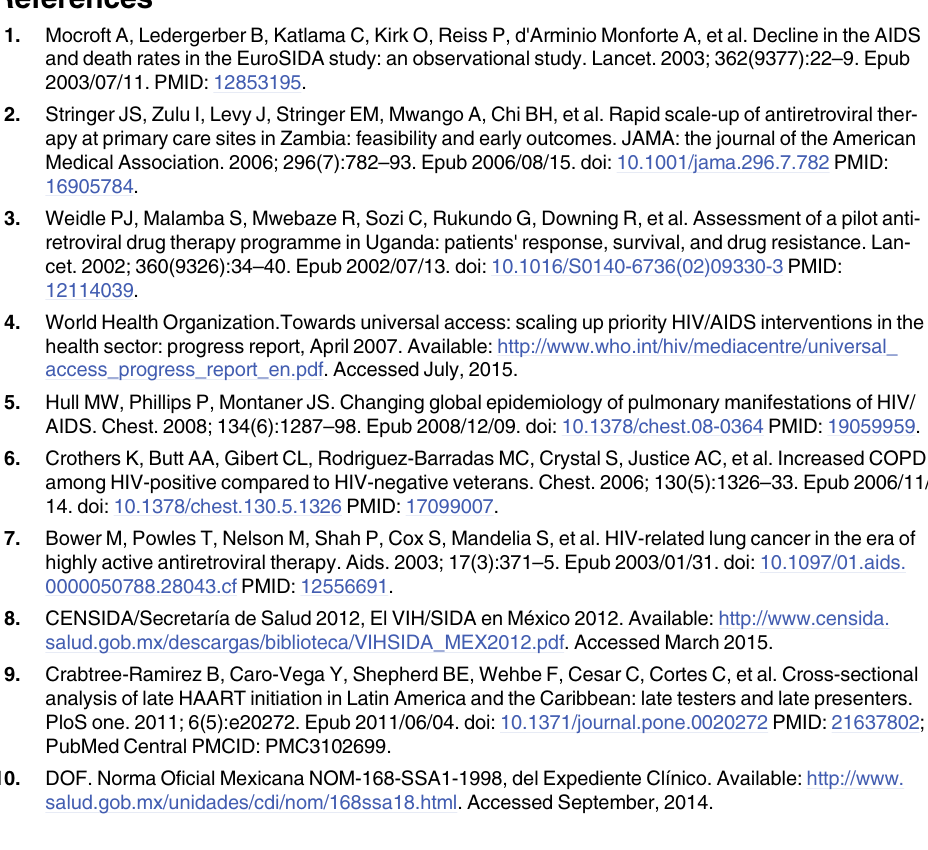
S1 Table. Type and frequency of discharge respiratory diagnosis among HIV/AIDS patients in a specialty hospital for respiratory diseases in Mexico City, from January 2010 to December